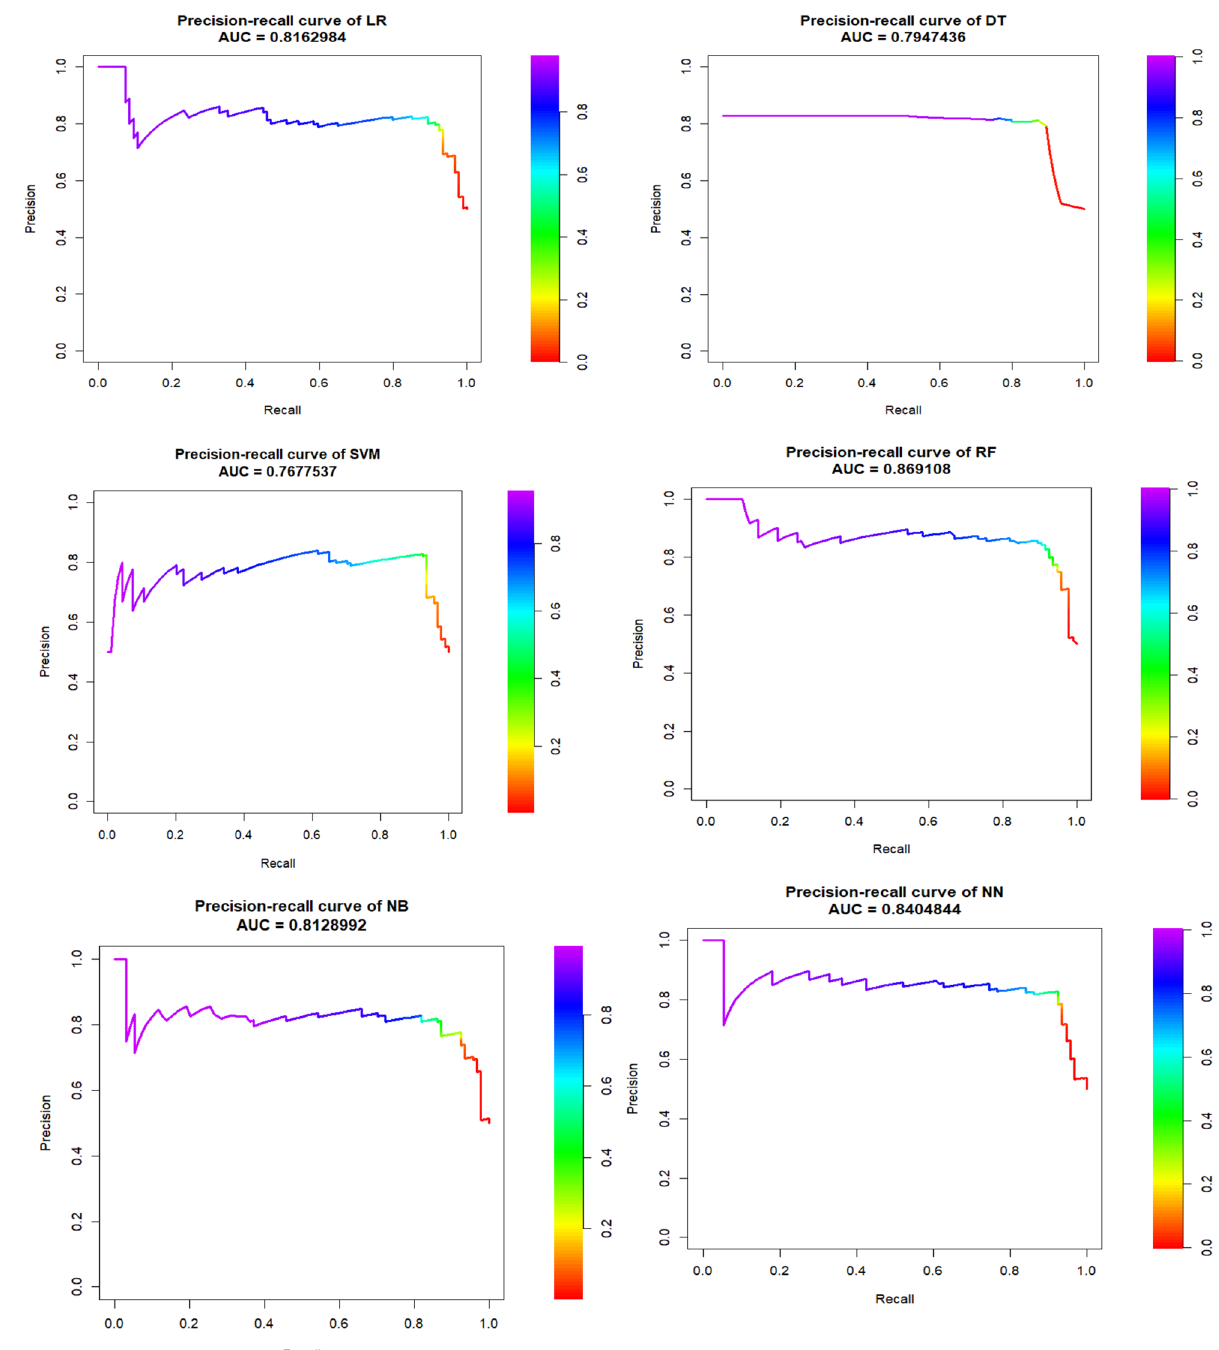
Figure 4. Precision-recall curve and its AUC in six ML algorithms of balanced test dataset of gastric cancer